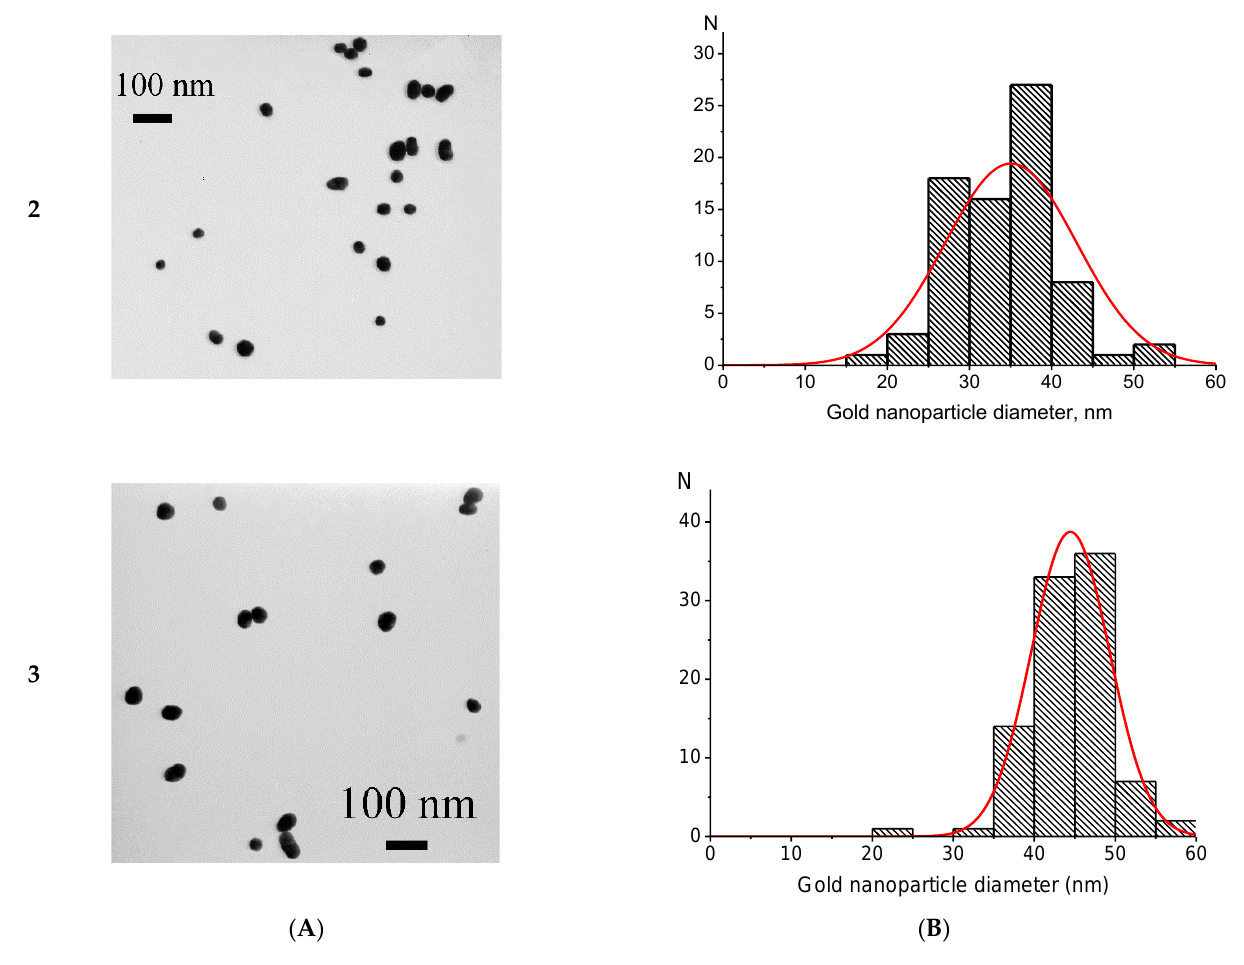
Figure 1. Electron microphotographs ( A ) of AuNPs1 ( 1 ), AuNPs2 ( 2 ), and AuNPs3 ( 3 ) and histograms of diameter distribution ( B ). Table 1. Characteristics of